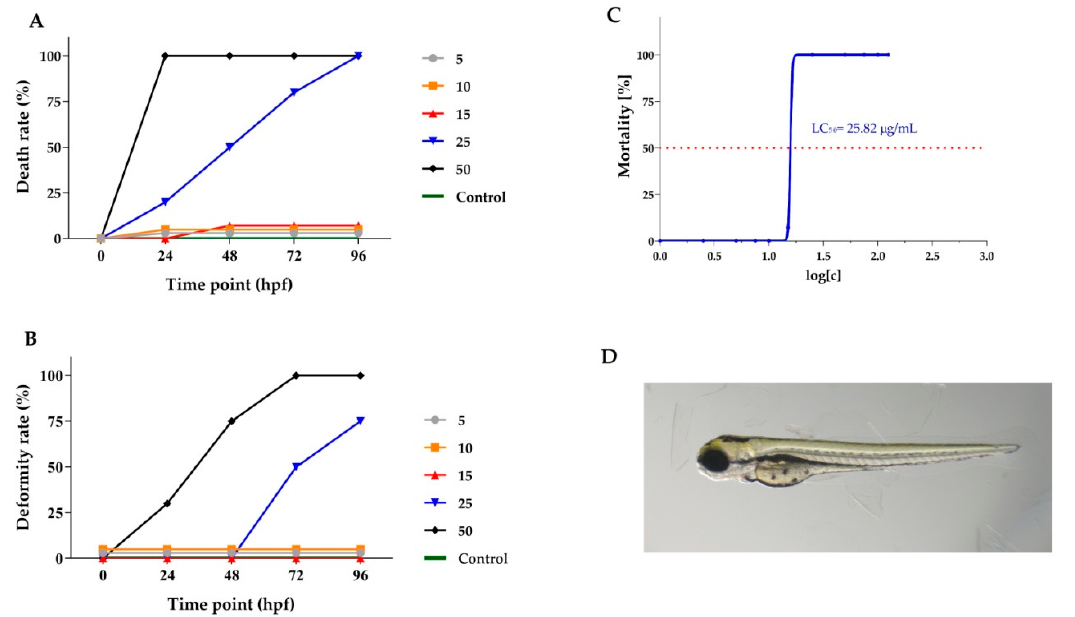
Figure 4. Toxicological analysis of Lamprocapnos spectabilis extract (concentration expressed in µg/mL). ( A ) Time–response curves of zebra fi sh embryo death rate during incubation with a dilution series of the L. spectabilis extract. ( B ) Time–response curves of deformity rate at tested doses. ( C ) Mortality of D. rerio larvae in a concentration-dependent manner to Lamprocapnos spectabilis extract exposure. The median lethal concentration (LC 50 ) was based on cumulative mortality obtained from three independent experiments at 96 h post fertilization (hpf). ( D ) Representative pictures of 96 hpf zebra fi sh exposed to 10 µg/mL Lamprocapnos spectabilis extract.